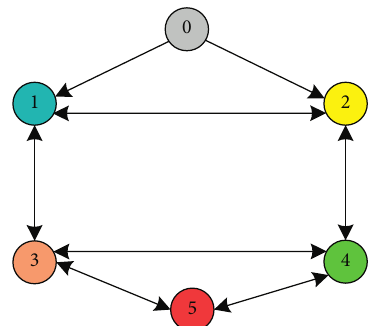
Figure 1: Communication topology for time-varying formation tracking case.